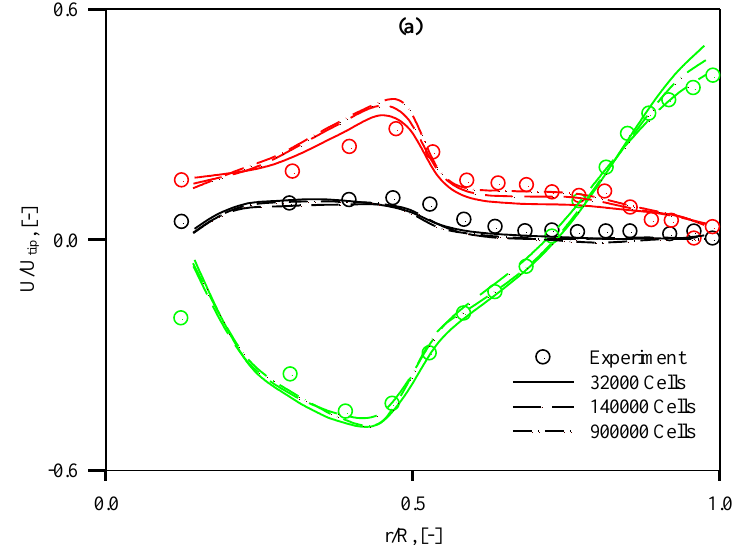
Figure 2. Comparison of dimensionless axial (green), radial (black) and tangential (red) velocity at z = 0.2H plane for computational grid with different